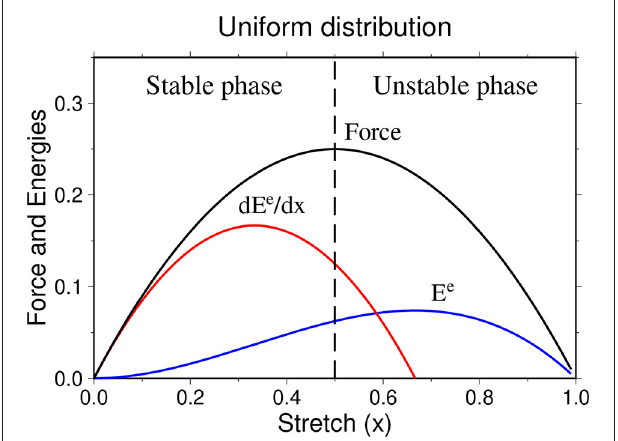
change rate (red curve) against the stretch x for uniform distribution of the fiber strengths in the